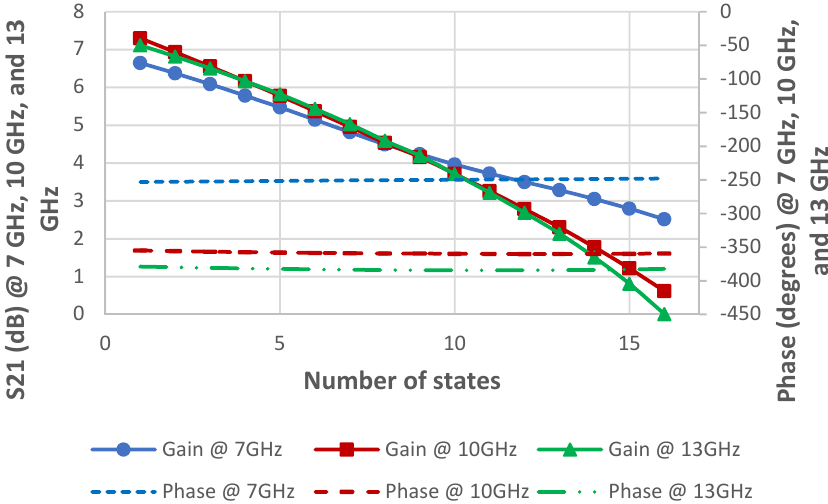
Figure 12. S21 and Phase versus number of states at the three test frequencies (7, 10, and 13 GHz).